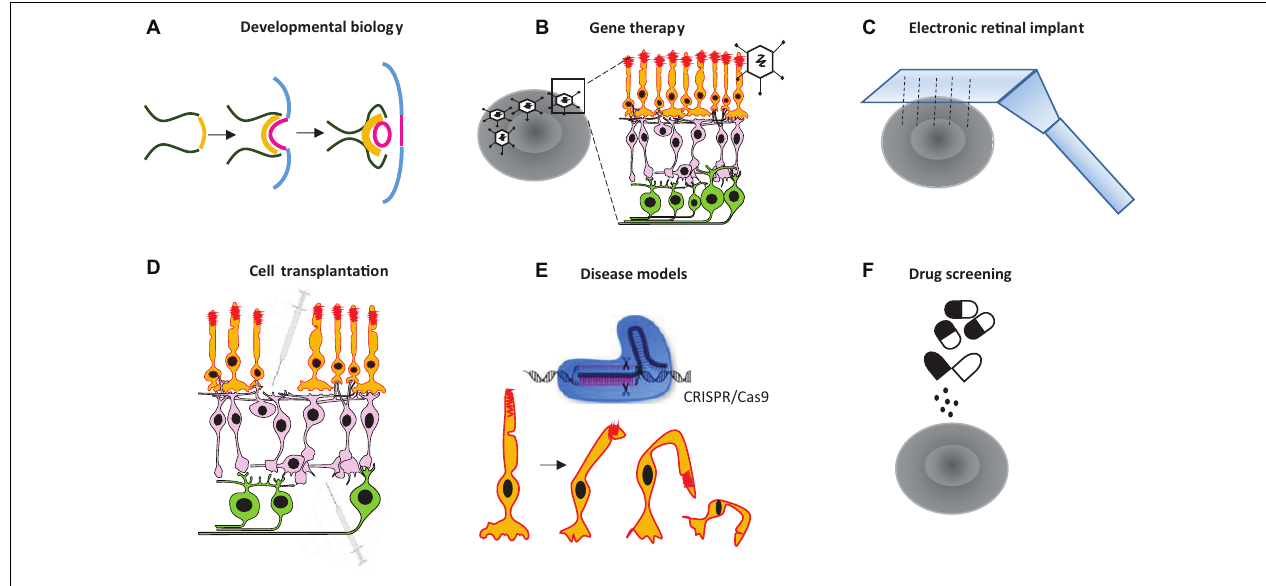
FIGURE 1 | Some potential applications for retinal organoid technology. Retinal organoids can be used to (A) study the development of the retina, (B) investigate various therapeutical approaches, including gene therapy for retinal disorders, (C) test electronic chip implants, (D) facilitate cell transplantation, (E) test human retinal disease models, and (F) conduct drug